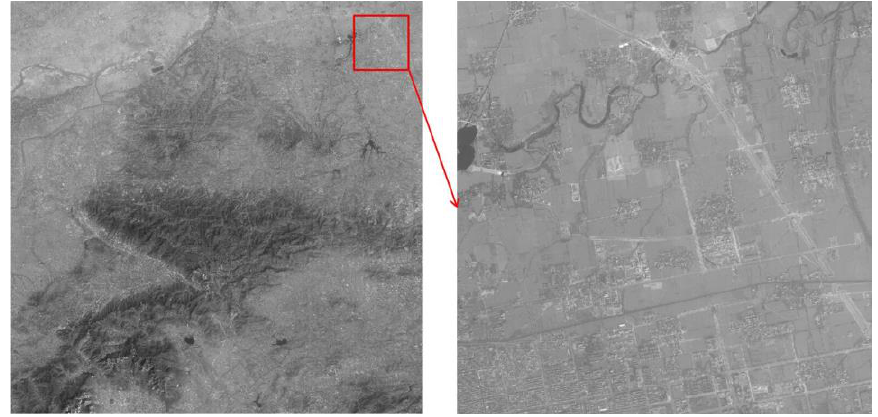
Figure 12. The result and its local amplification effect of the images after image dodging by the improved method.